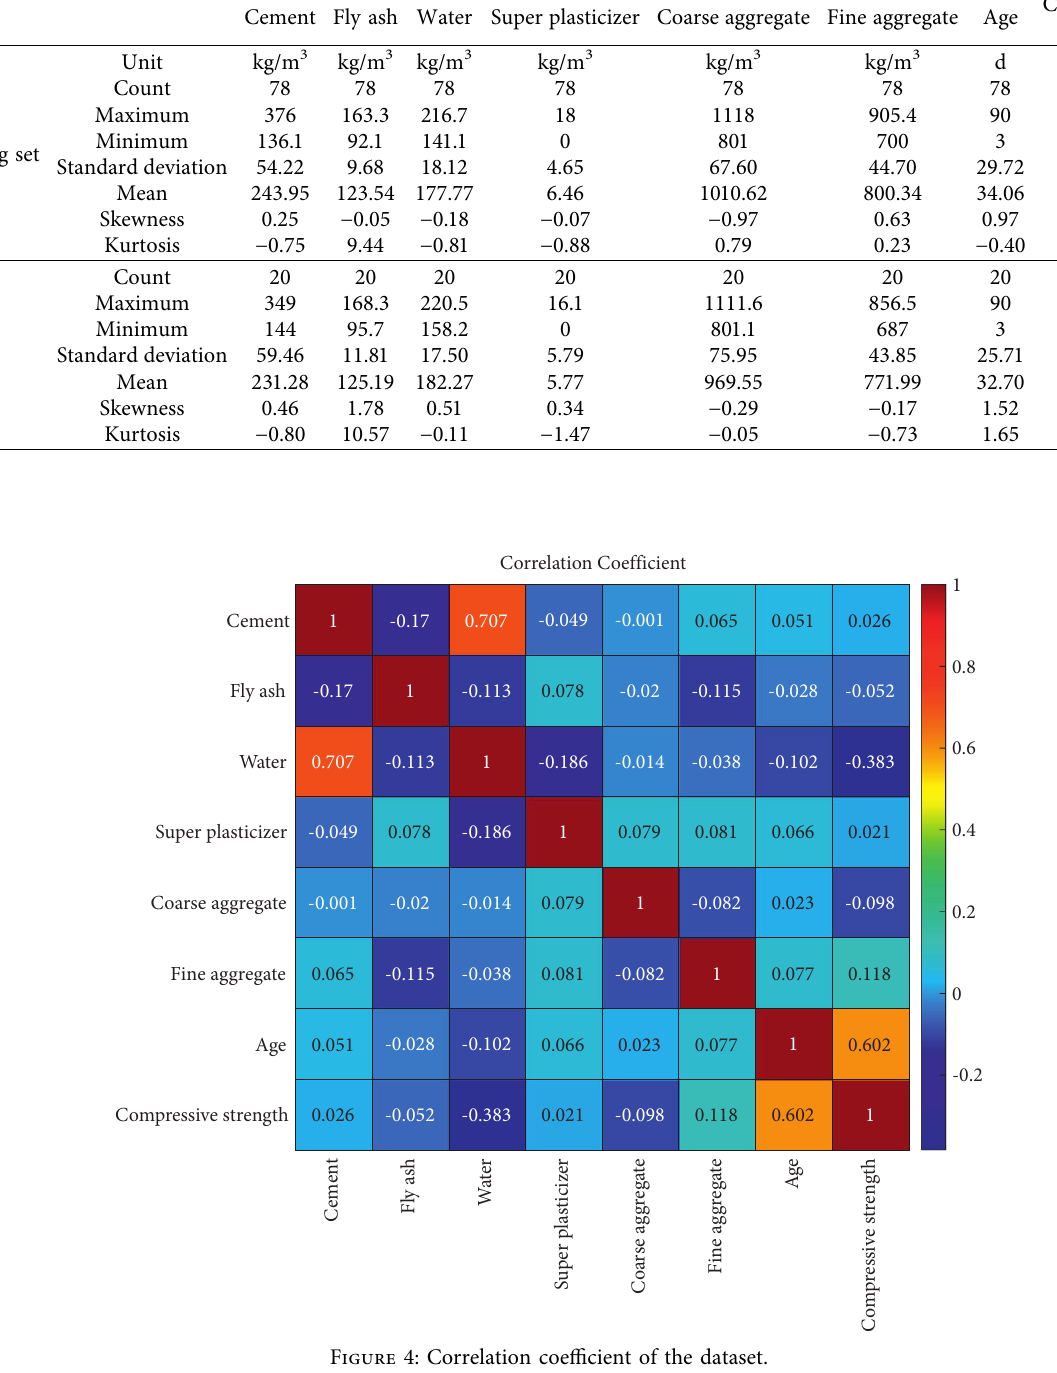
Table 1: Statistical characteristics of variables.